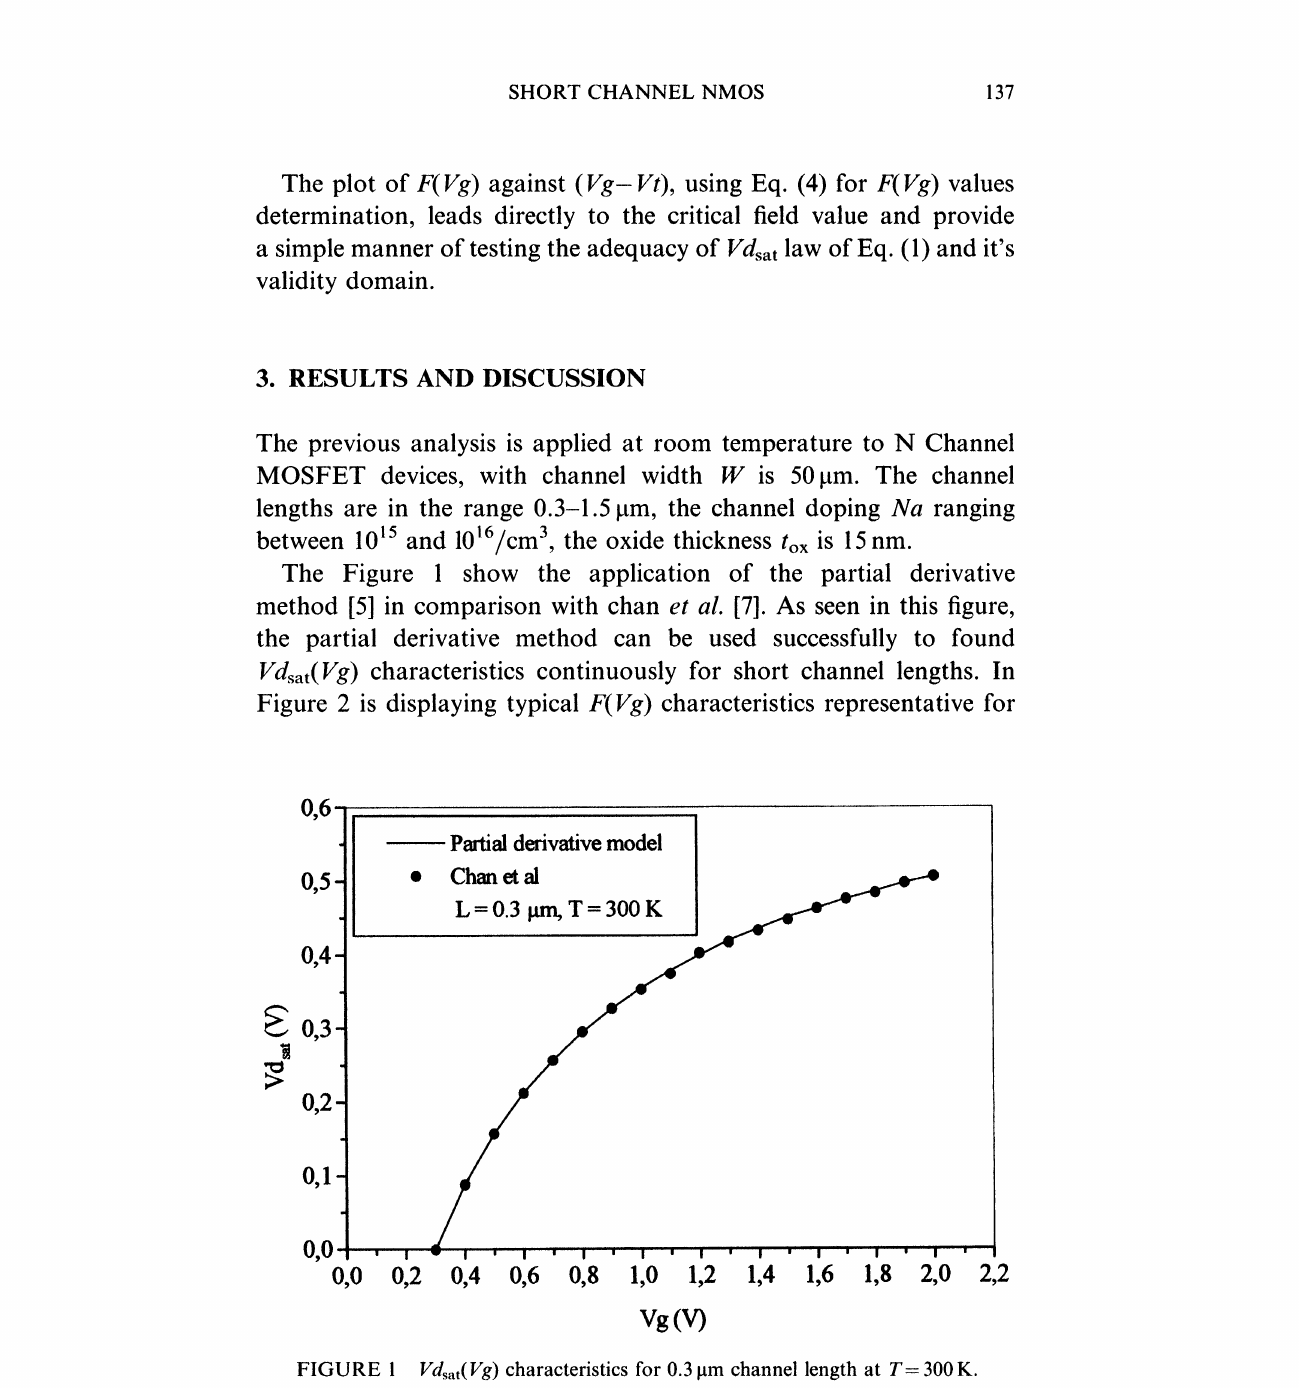
FIGURE Vdsat(Vg characteristics for 0.3 Ixm channel length at T= 300